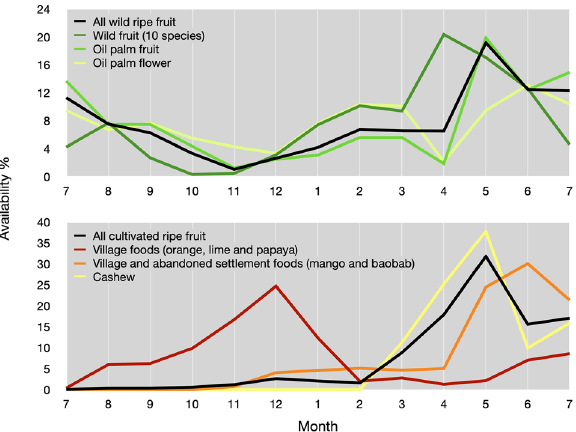
Figure 3. Monthly variation in availability of chimpanzee key food sources in 2017–2018 in Caiquene– Cadique, Cantanhez National Park. Frequency of availability is the mean availability index of resource or group of resources k scaled by the total availability during the study period (12 months). Village foods include the combined availability of orange, lime and papaya ripe fruit; village and abandoned settlement foods include the combined availability of mango and baobab ripe fruit; wild fruit include the combined availability of ripe fruit of ten important chimpanzee food species (Supplementary Figs. S2–S3).